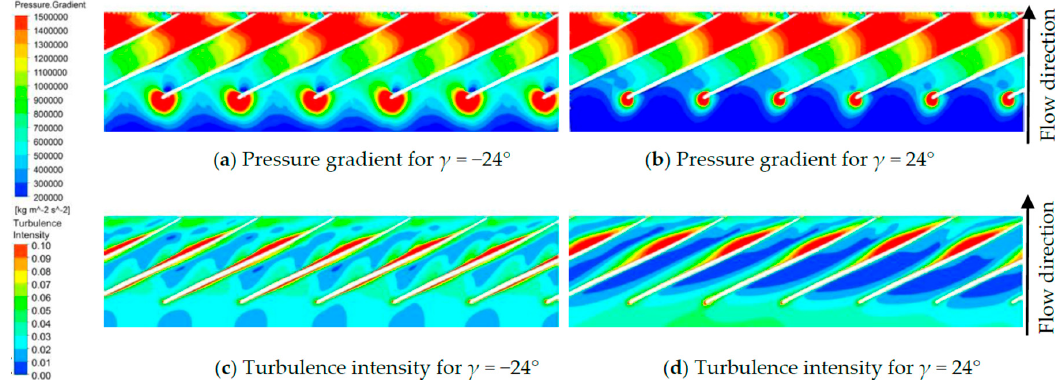
Figure 9. Pressure gradient and turbulence intensity distribution at the middle span of the impeller.